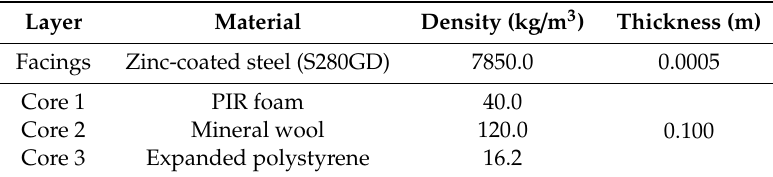
Table 3. Nominal geometrical and mechanical properties of the sandwich panel layers used in the